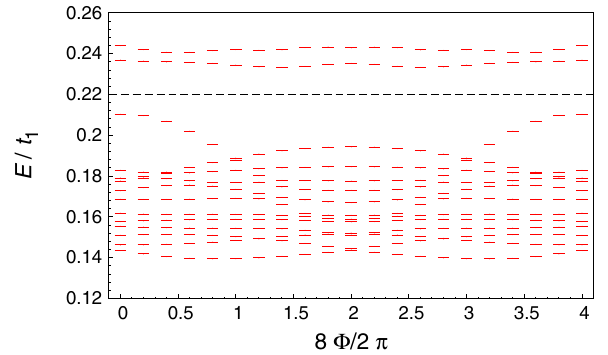
FIG. 8. Evolution of the low-energy spectrum for N ¼ 7 , 8 , N 3 at K 2 , K 0 upon flux insertion along N x ¼ y ¼ x ¼ y ¼ the x direction. The number of states below the dashed line is